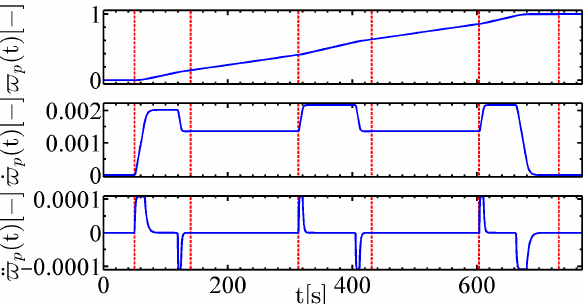
Figure 15: Position and heading (NED frame).